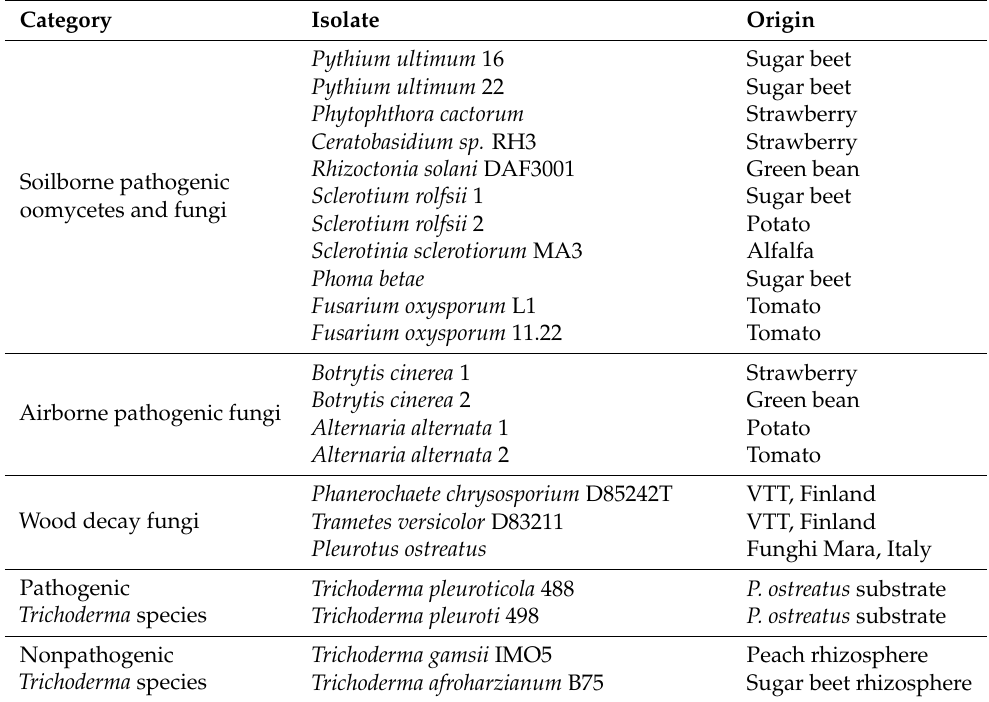
Table 1. List of the fungal and oomycetes isolates assayed in the preliminary in vitro experiments.